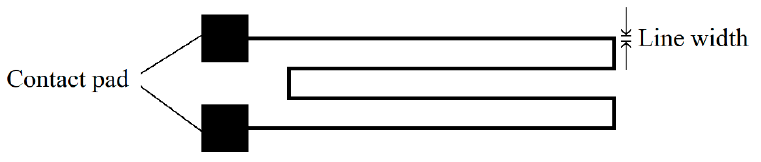
Figure 4. Schematic design of the metallic test structures (not to scale).